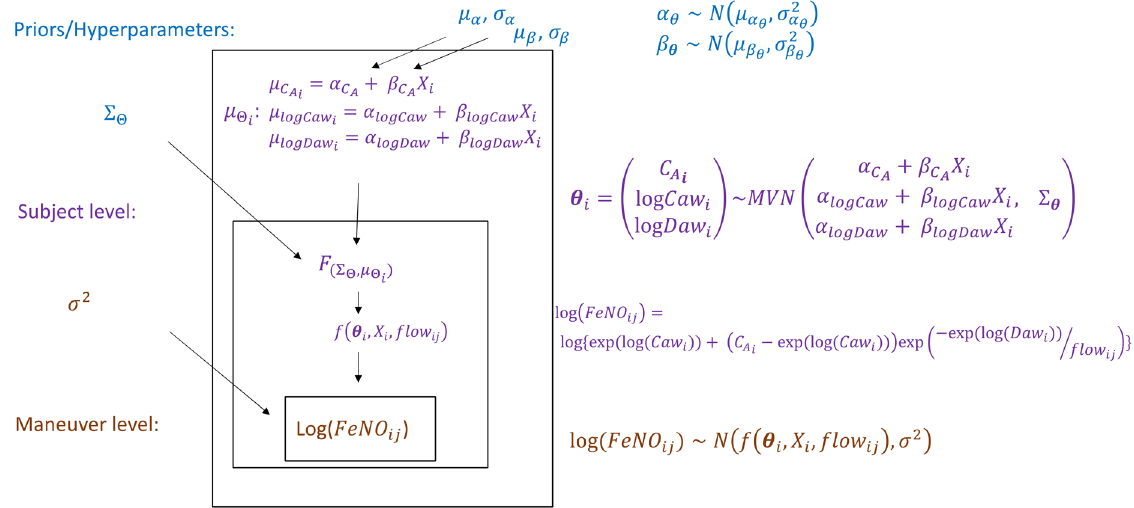
Figure 1. Hierarchical model structure relating FeNO measurements at multiple flow rates to NO parameters that are a function of a potential determinant X (e.g., air